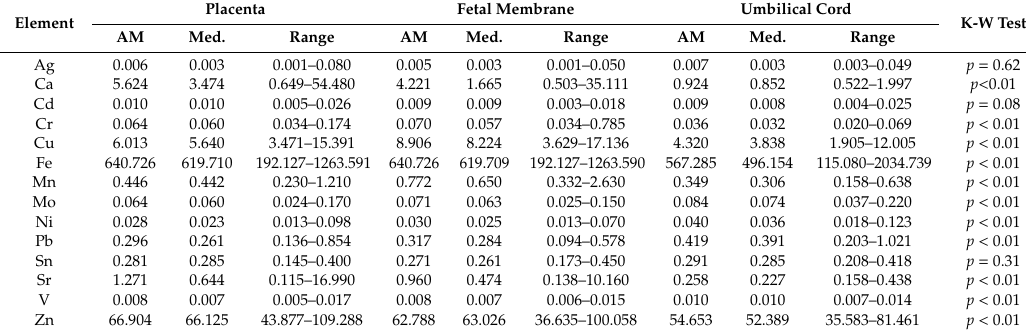
Table 2. Concentrations of Ag, Ca, Cd, Cr, Cu, Fe, Mn, Mo, Ni, Pb, Sn, Sr, V, and Zn in the human placenta, fetal membrane and umbilical cord (AM, arithmetic mean; K-W test, Kruskal–Wallis test; Ca concentrations are expressed in g / kg dw and Ag, Cd, Cr, Cu, Fe, Mn, Mo, Ni, Pb, Sn, Sr, V, as well as Zn levels are expressed in mg / kg